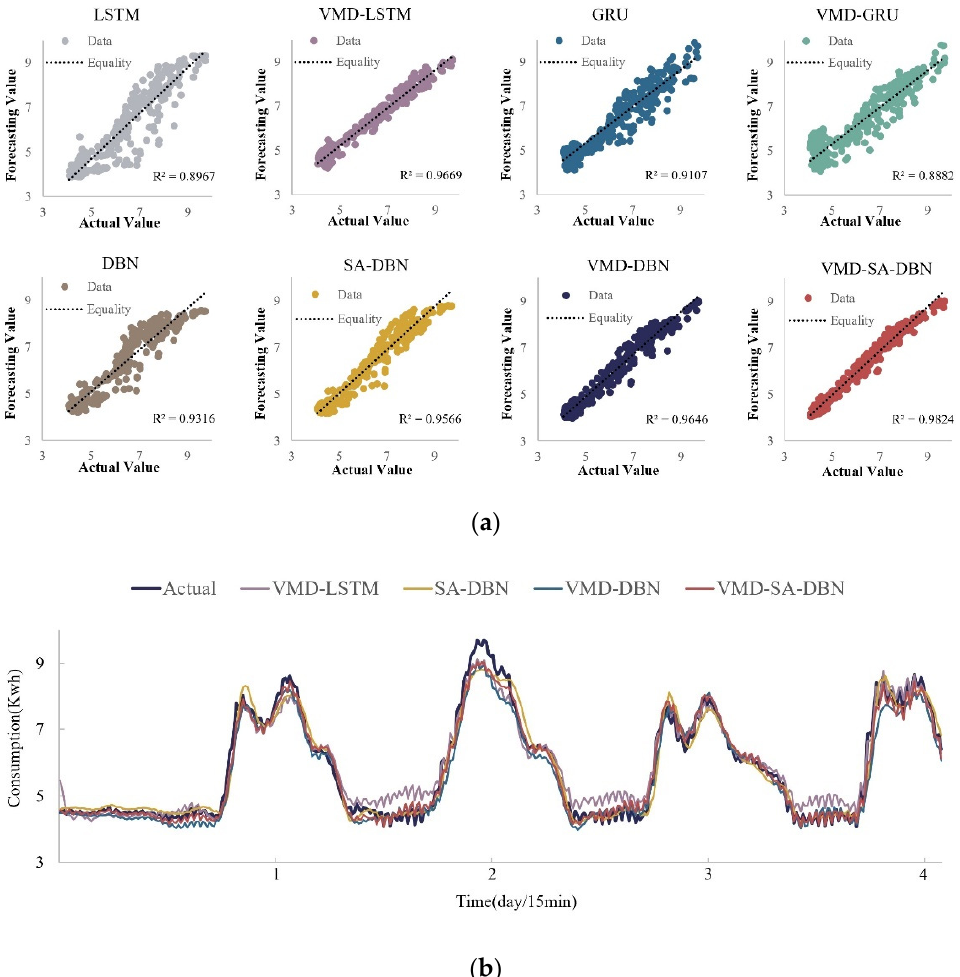
Figure 4. Comparison of prediction results of different models. ( a ) The fit plots of the predicted data of different models to the actual data, ( b ) The line graph of predicted data from different models versus actual predicted data.